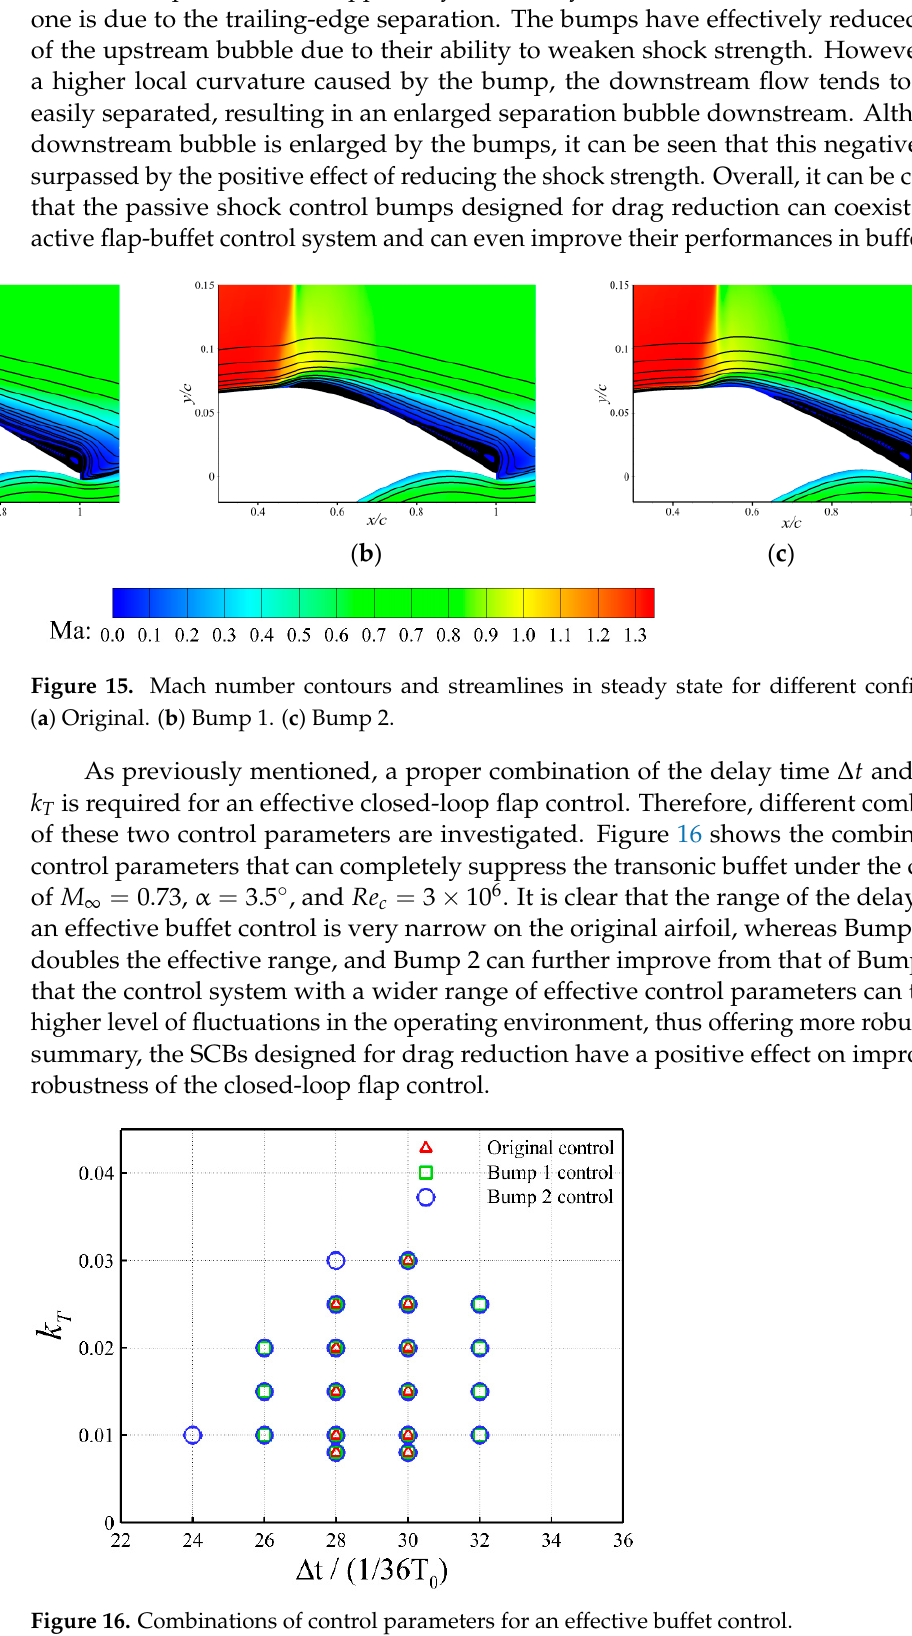
Figure 16. Combinations of control parameters for an effective buffet control.